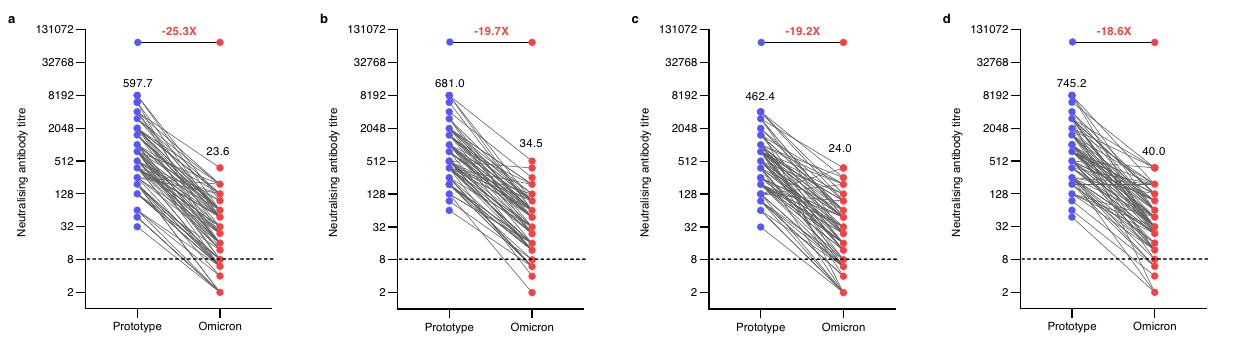
Table 3 | Adverse reactions within 28 days after the third dose